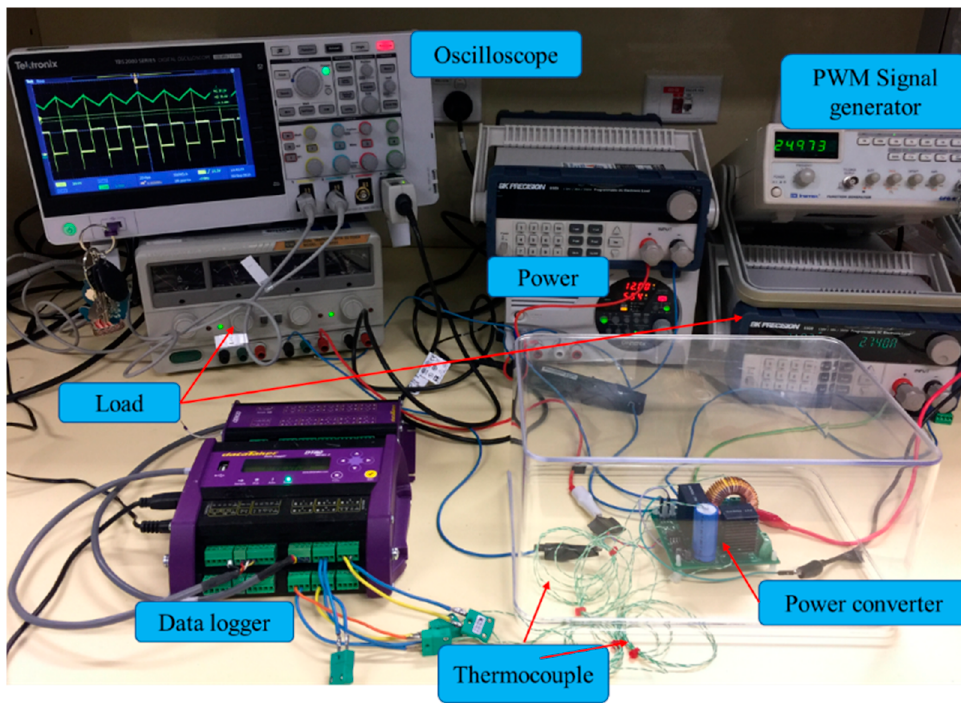
Figure 4. Thermal coupling testing platform of the power converter.